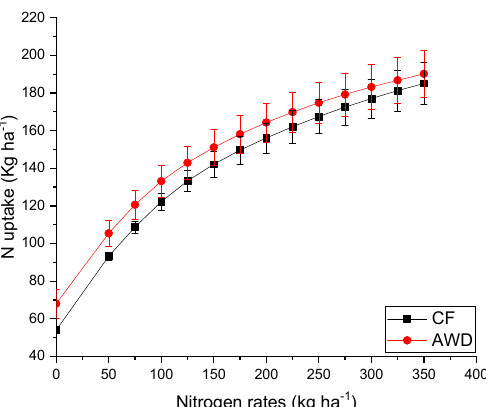
Figure 6. Simulated yield and applied fertilizer N, with AWD and CF conditions. Each value is the average of 45 years between 1961 and 2005. The bars show the standard deviation among years for each N rate.